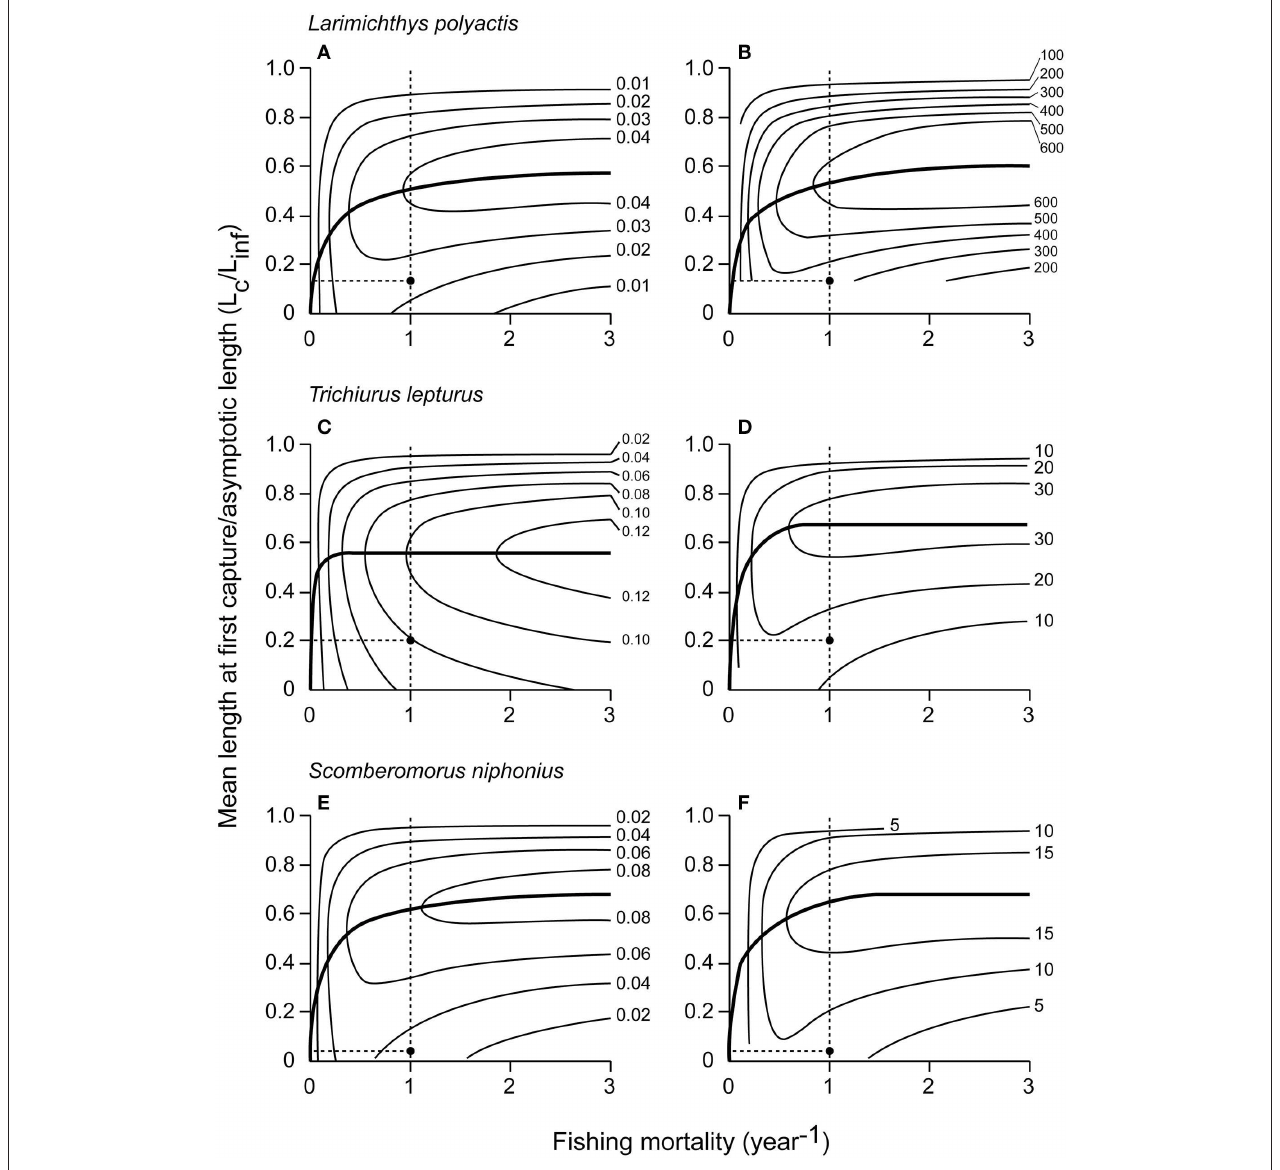
FIGURE 3 | Assessments of 3 fish species from Chinese coastal waters: Y ′ /R (left) and U/R (right) isopleth diagrams vs. fishing mortality and L c /L inf . The solid curves connect optimum sizes for different every level of fishing mortality and the black dots and dotted lines show the current status of the fishery status in level. U/R for L. polyactis is in Yuan, and in 1,000 Yuan for T. lepturus and S. niphonius . (A) L. polyactis Y ′ /R vs. fishing mortality and L c /L inf . (B) L. polyactis U/R vs. fishing mortality and L c /L inf . (C) T. lepturus Y ′ /R vs. fishing mortality and L c /L inf . (D) T. lepturus U/R vs. fishing mortality and L c /L inf . (E) S. niphonius Y ′ /R vs. fishing mortality and L c /L inf . (F) S. niphonius U/R vs. fishing mortality and L c /L inf